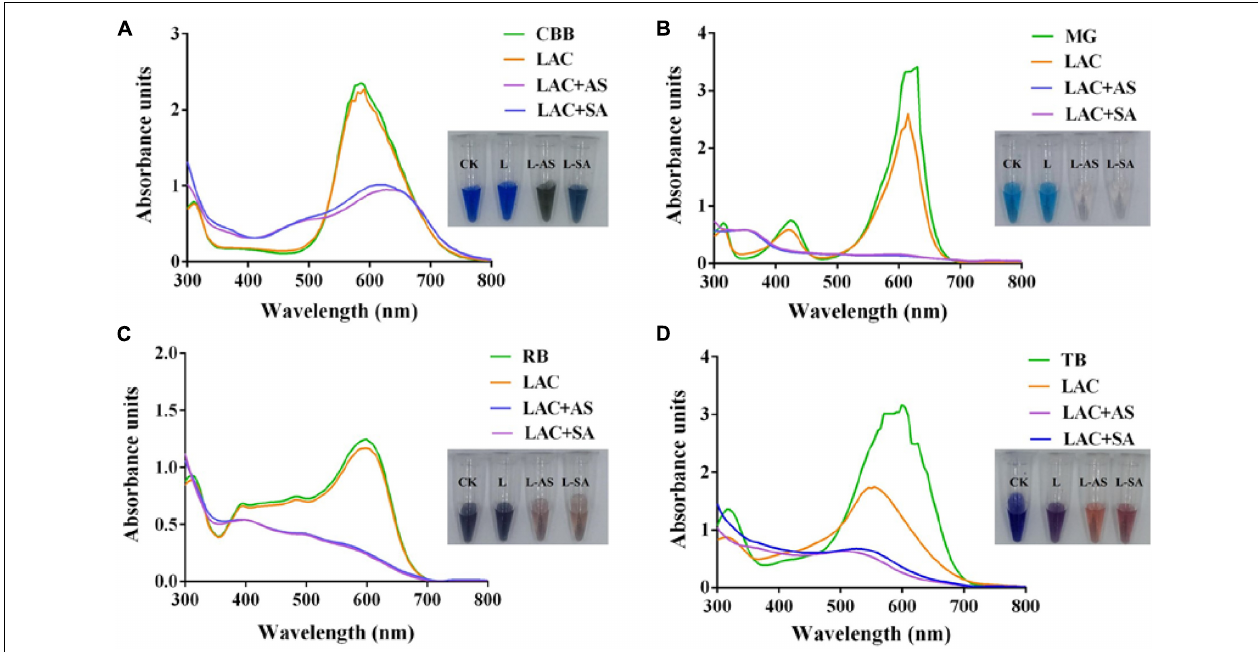
FIGURE 6 | Full-wavelength scanning (300–800 nm) of reaction products of LMS for dye decolorization. (A) Coomassie brilliant blue G250 (CBB); (B) malachite green (MG); (C) reactive black (RB); (D) trypan blue